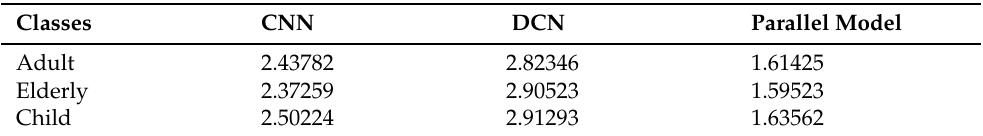
Table 6. Entropy values of the class activation maps (CAMs) from CNN and DCN modules and the parallel model. The entropy values and the classification accuracy have a correlation on classification accuracy, caused by the unpredictability, which can be seen in Table